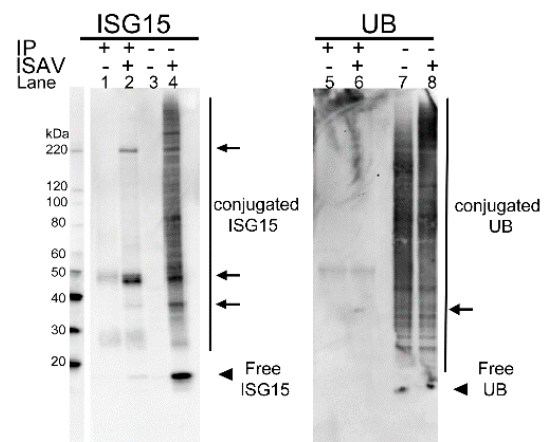
Figure 5. Western blots of co-immunoprecipitation (IP) assays with s8ORF2 and ISAV proteins NP, M and F. Four days post infection of ASK cells, IP shows that s8ORF2 protein interacts with the ISAV nucleoprotein (NP), matrix protein (M) and fusion protein (F). Cell lysates from non-infected ( ´ ) or ISAV infected cells (+) were IP with either anti-s8ORF2 antiserum, anti-NP mAb, anti-M- or anti-F antiserum, or run directly on western blots (WB) without IP ( ´ ). ( A ) WB with anti-s8ORF2 antiserum; ( B ) WB with anti-NP antibody; ( C ) WB with anti-M antiserum. Arrows mark bands representing full-length proteins. Additional bands might represent cleavage products except (*) that is unspecific